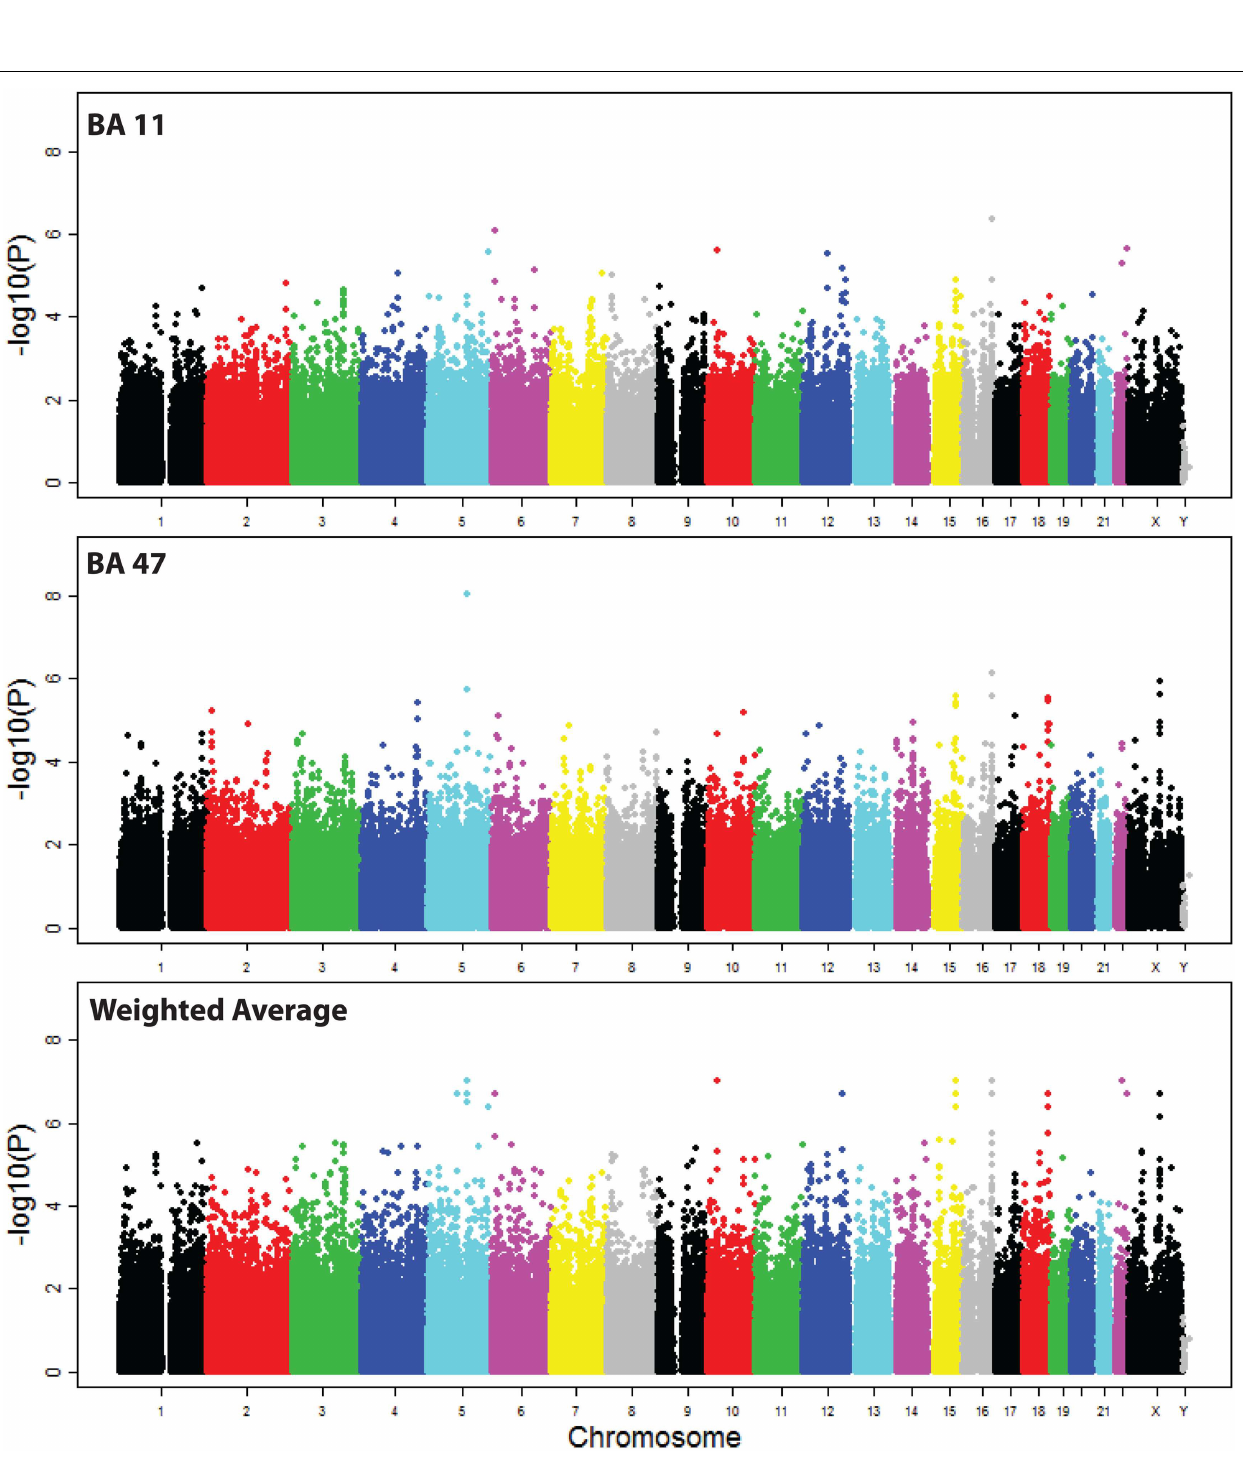
FIGURE 2 | Manhattan plot of SNP associations withVSNL1 expression . Associations are shown for each region, and for the weighted average of the two regions in the meta-analysis. BA, Brodmann area.